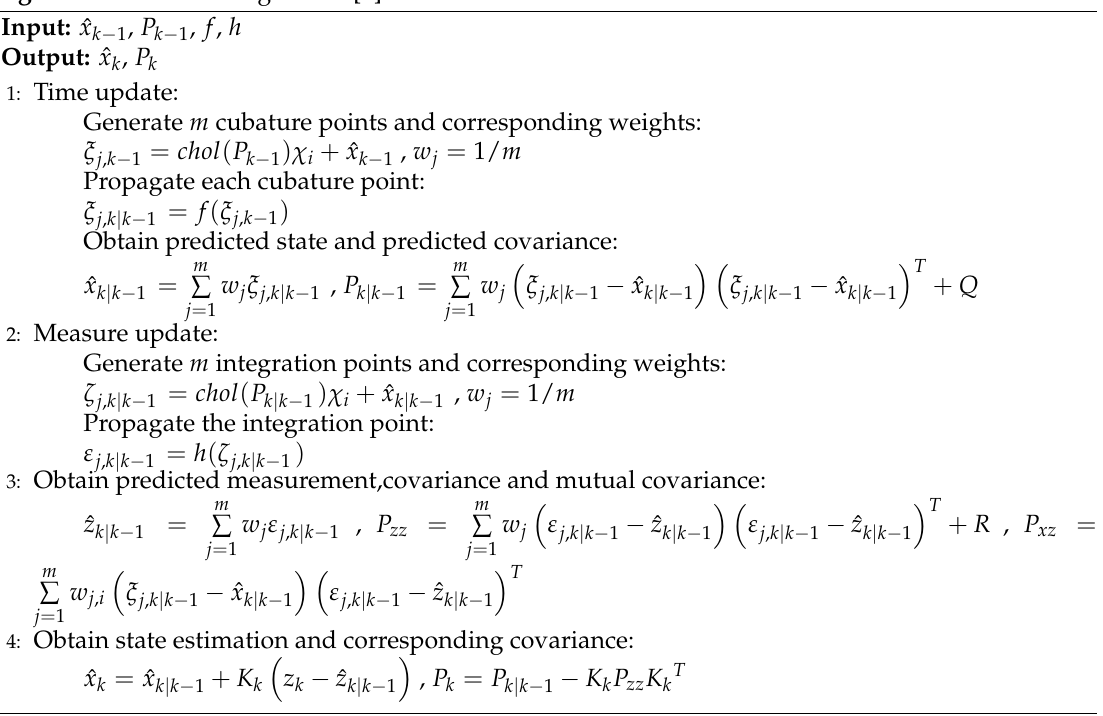
Algorithm 1 The CKF algorithm [8] for one